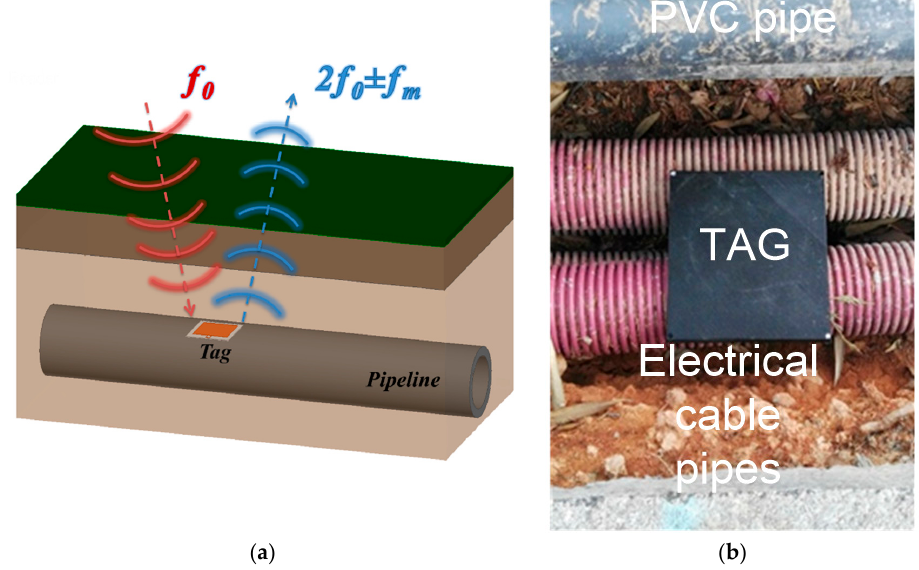
Figure 1. Block diagram of the proposed harmonic system ( a ) and an image of a typical installation ( b ).